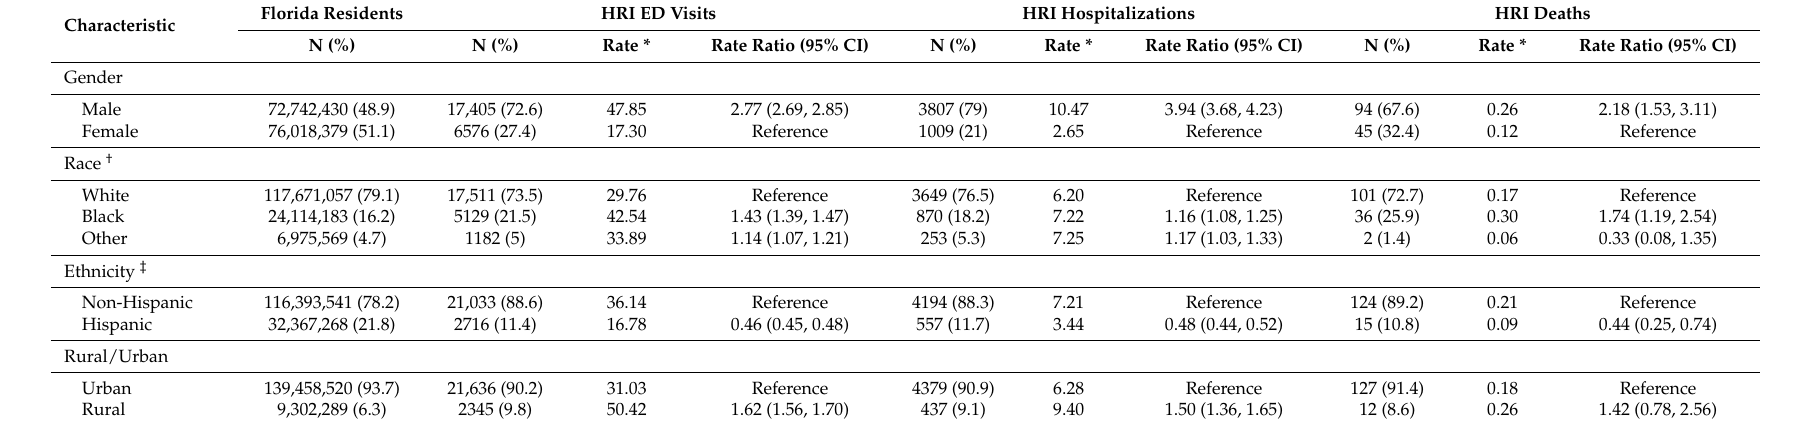
Table 2. Distribution of non-work-related HRI among Florida residents by selected characteristics (2005–2012).